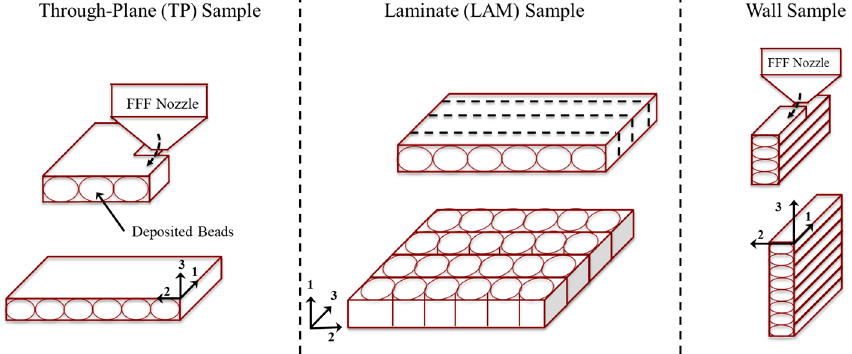
Figure 2. Illustration of laser flash analysis (LFA) sample preparation. From left to right, the sample is printed and a through-plane (TP) sample is scanned through the thickness. The same sample may be cut, and each strip is rotated, making a laminate (LAM) sample, which is also scanned through the thickness. Other samples are printed as walls to scan across the bead width. The 1-direction is the principal fiber orientation direction and the printing direction. The 2-direction is the crossflow, and the 3-direction is the through-plane or build direction.